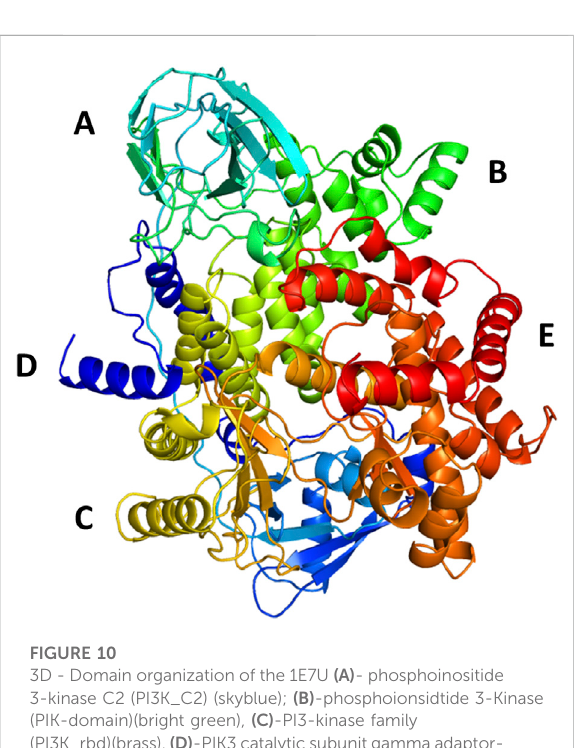
FIGURE 10 3D - Domain organization of the 1E7U (A) - phosphoinositide 3-kinase C2 (PI3K_C2) (skyblue); (B) -phosphoionsidtide 3-Kinase (PIK-domain)(bright green), (C) -PI3-kinase family (PI3K_rbd)(brass), (D) -PIK3 catalytic subunit gamma adaptor- binding domain (PIK3CG_ABD domain) (dark blue) and (E) - phosphatidylinositol 3 and 4-kinase (PI3_PI4 kinase domain)